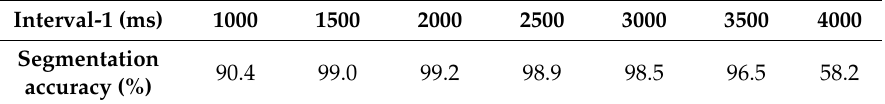
Figure 7. Description of the continuous gesture segmentation principle based on the process of a triangular HMT gesture. Table 2. Segmentation accuracy with different time-window widths of interval-1.